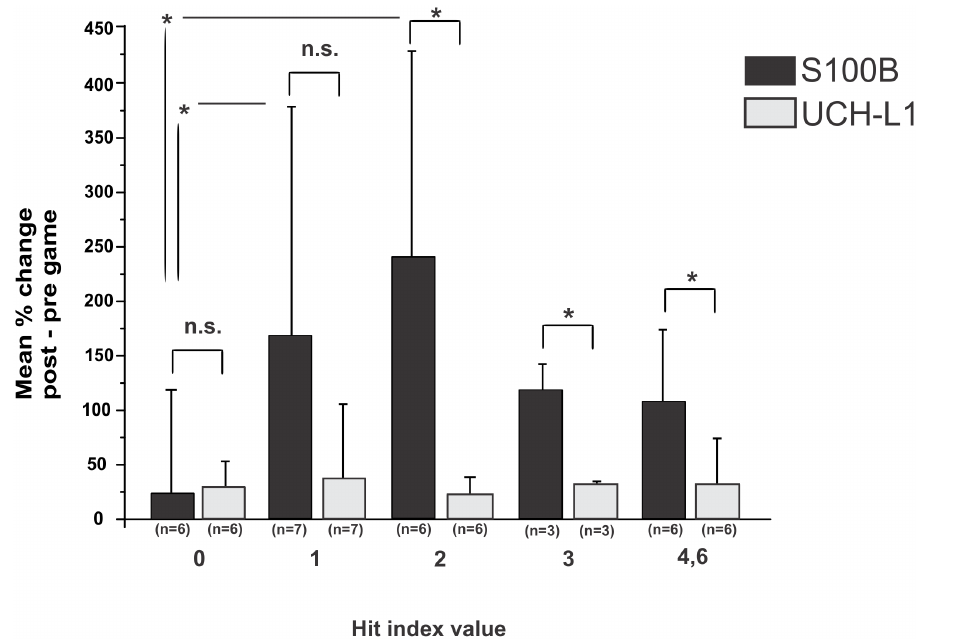
Figure 2. S100B serum surges correlate with the extent and number of head hits, while UCH-L1 does not appear to correlate with sub-concussive head hits. Mean percent change values of S100B and UCH-L1 levels (see equation (1)) were plotted against Head Hit Index (HHI) scores (see Methods). A statistically significant difference (by Wilcoxon Mann Whitney) was found between S100B surges at HHI of 0 and HHI of 1 and 2. UCH-L1 did not correlate with any of the HHI used for this study, and the levels of UCH-L1 measured after the game and normalized for their pre- game value as in (1) did not discriminate between a HHI of 0 (special team or played without any head hit) and any HHI (see also [10] for details on HHI). Statistical differences were analyzed by the Wilcoxon Mann Whitney test, both in the comparison between S100B and UCH-L1 at a particular HHI and in the comparison of the individual marker at a HHI 0 vs. HHI 1, 2, 3, and 4,6. To correct for type 1 error in multiple comparisons the Dunnett’s correction was used. Significance is shown as (*) for p , 0.05; and n.s. for not